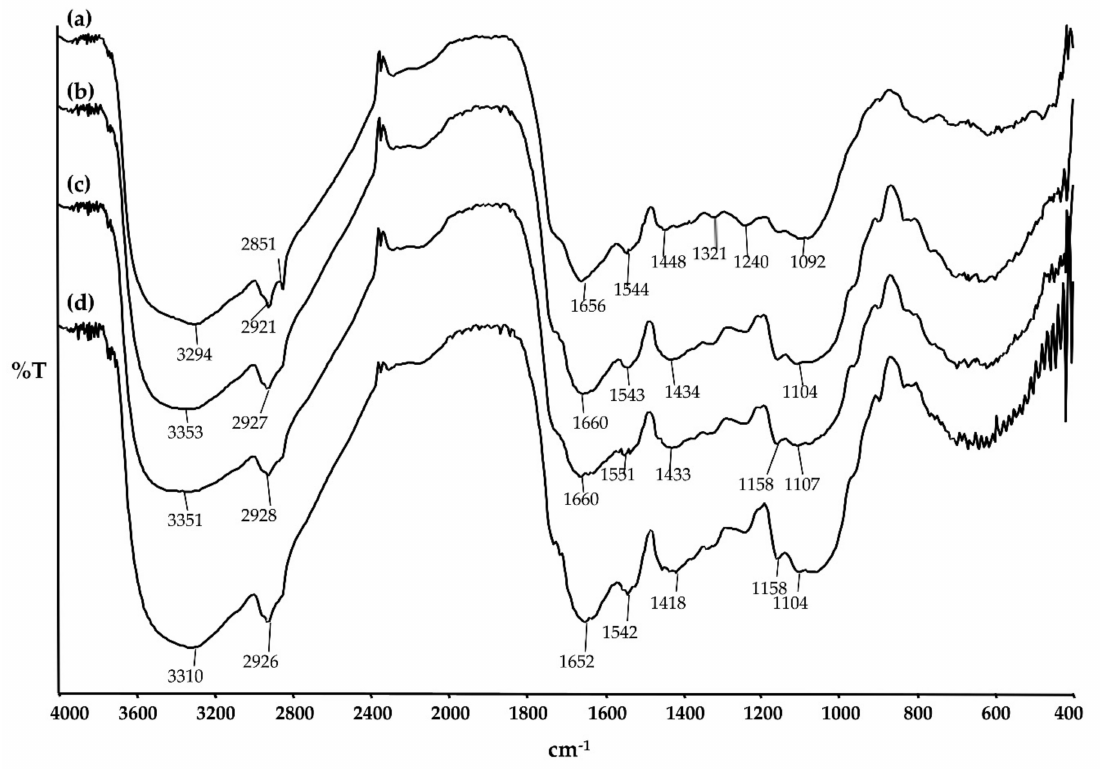
Figure 6. FTIR spectra of raw ( a ), Ni 2 + -loaded ( b ), Zn 2 + -loaded ( c ), and (Ni 2 + + Zn 2 + )-loaded ( d ) Lemna gibba